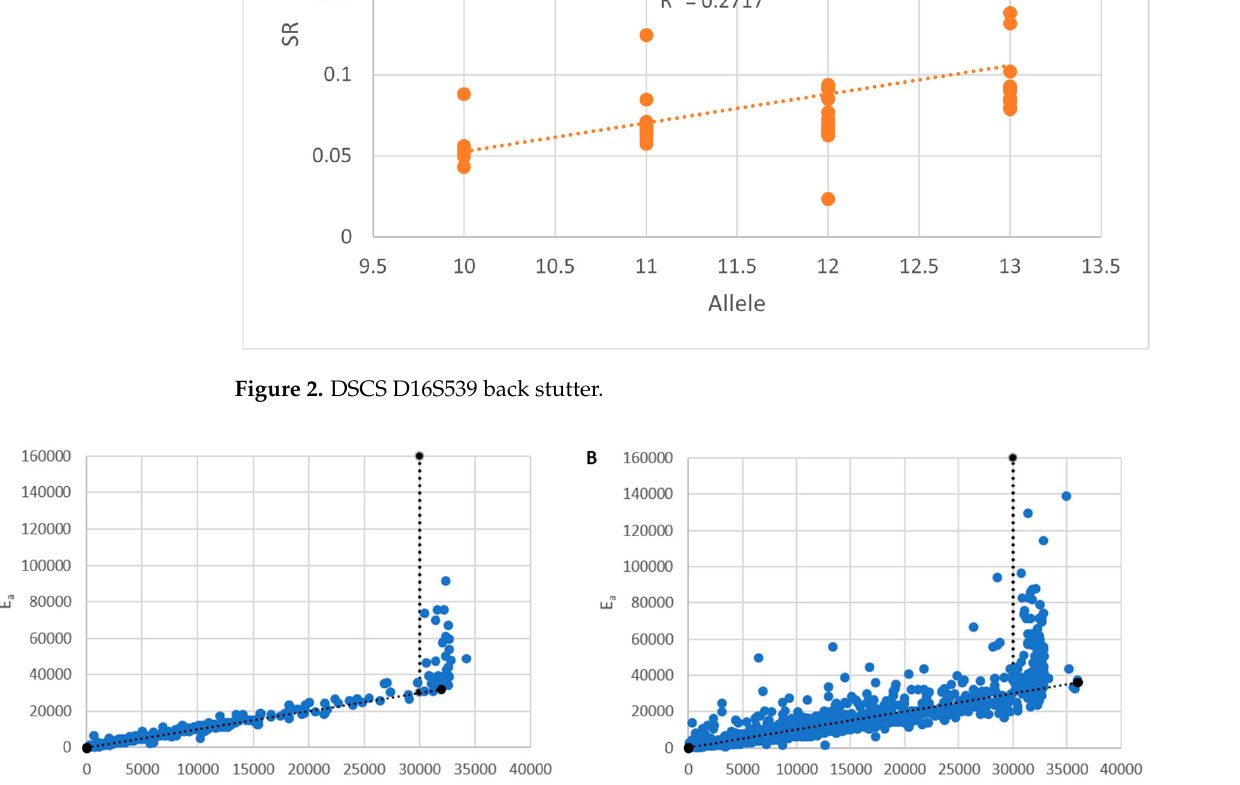
Figure 3. Applied Biosystems TM 3500 Genetic Analyzer saturation threshold (DSCS) ( A ) Standard Analysis ( B ) DSCS. Compared to standard analysis, DSCS samples have a greater discrepancy in